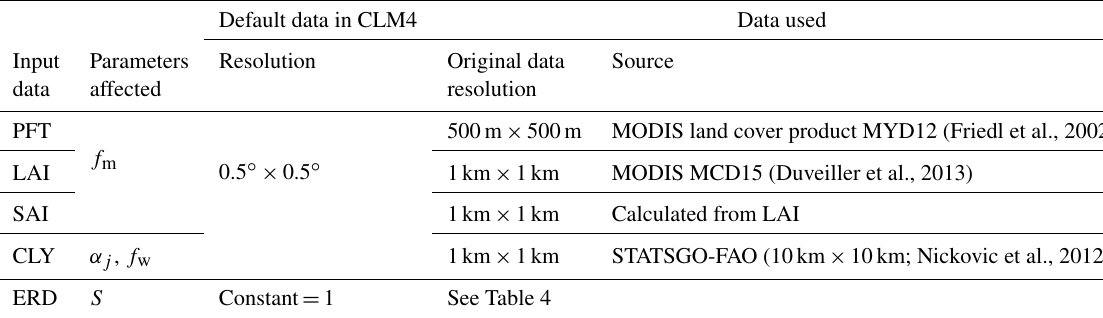
Table 2. Land surface data used in model setup.